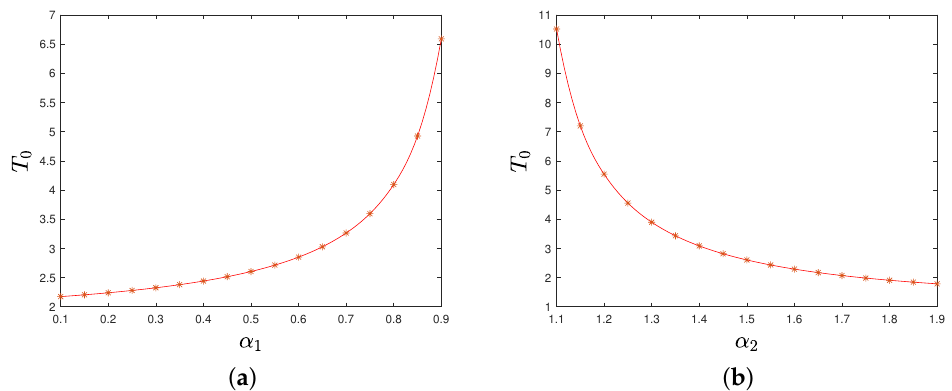
Figure 5. ( a ) Time evolutions of parameters α 1 = 0.1,0.3,0.5,0.7,0.9; ( b ) time evolutions of strategy (8) for different parameters α 2 = 1.1,1.3,1.5,1.7,1.9.